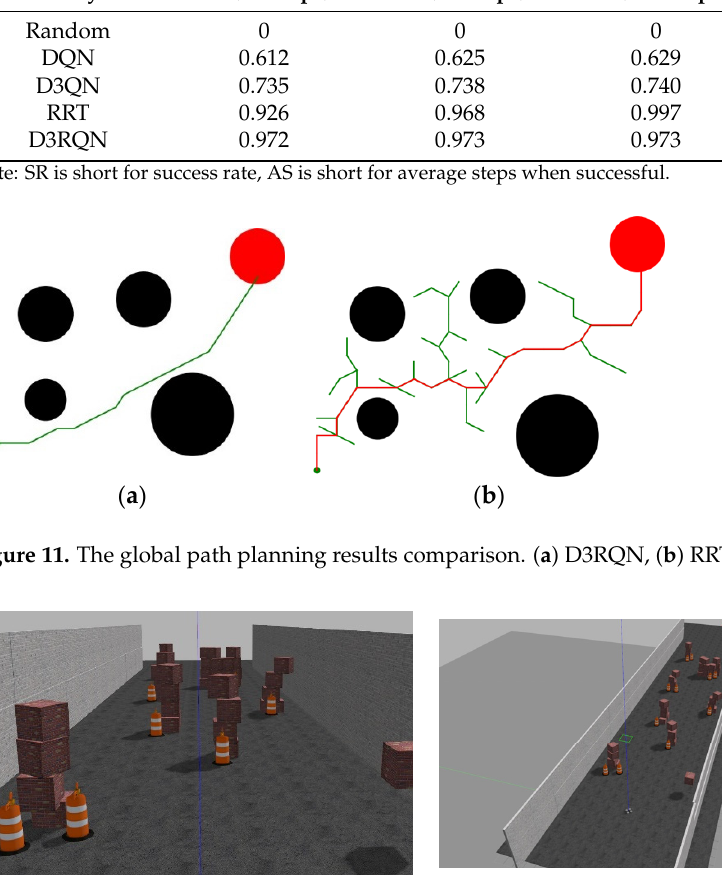
Table 7. Hyperparameters of Training the